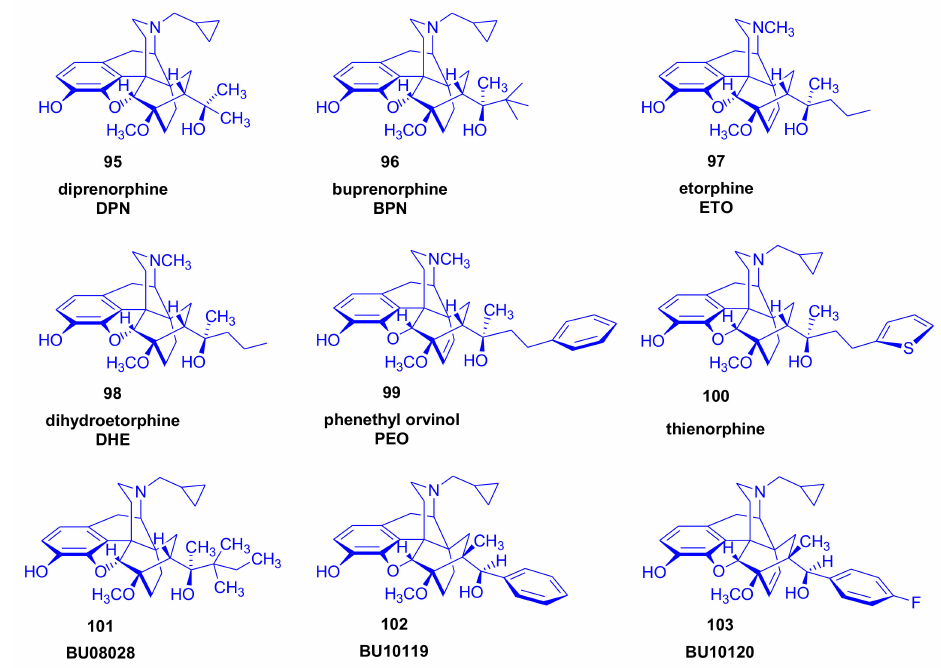
Figure 32. Structures of selected pharmacologically important orvinol